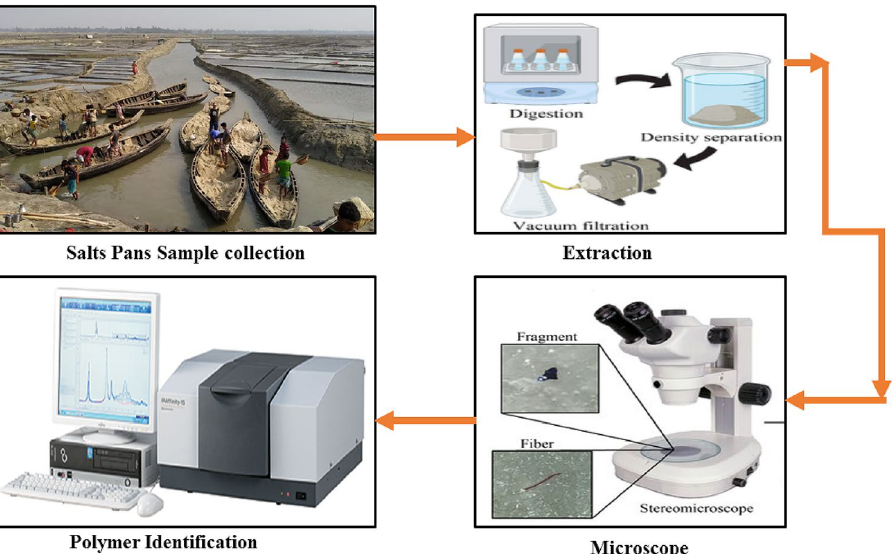
Figure 2. Procedural steps for microplastics analysis in sea salts samples. This diagram was constructed using PowerPoint